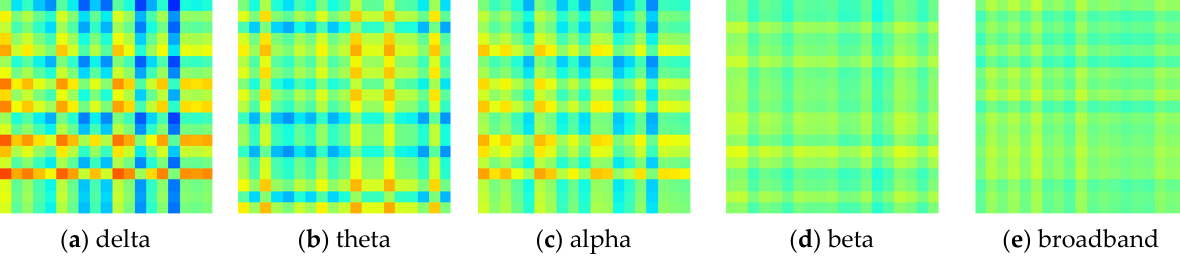
Figure 10. Example of moderate sample (BDI score is 22)’s deep-asymmetry image by each band.